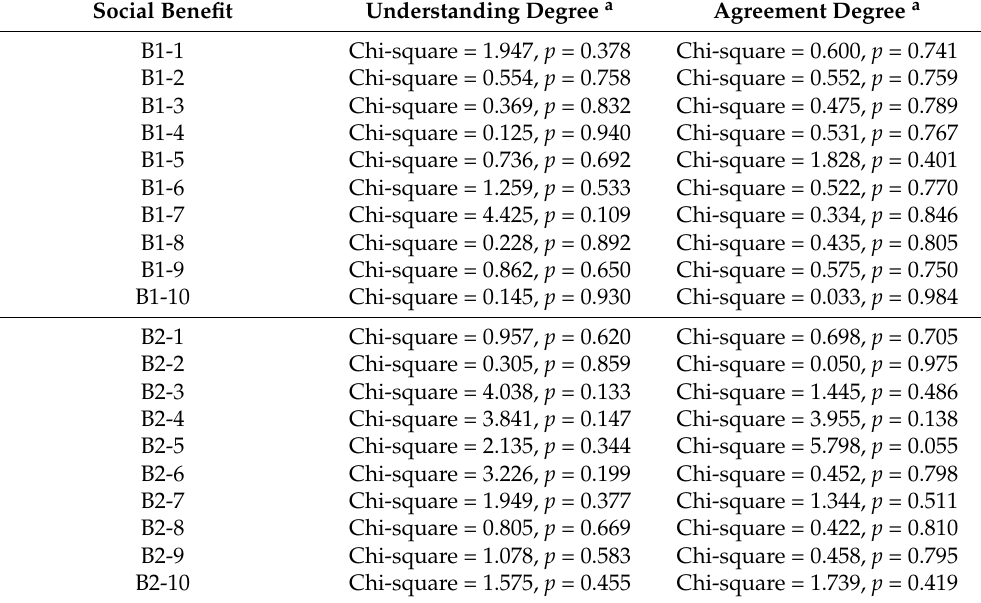
Table 4. The impacts of childhood living environments on respondents’ perceptions of UGS’ social